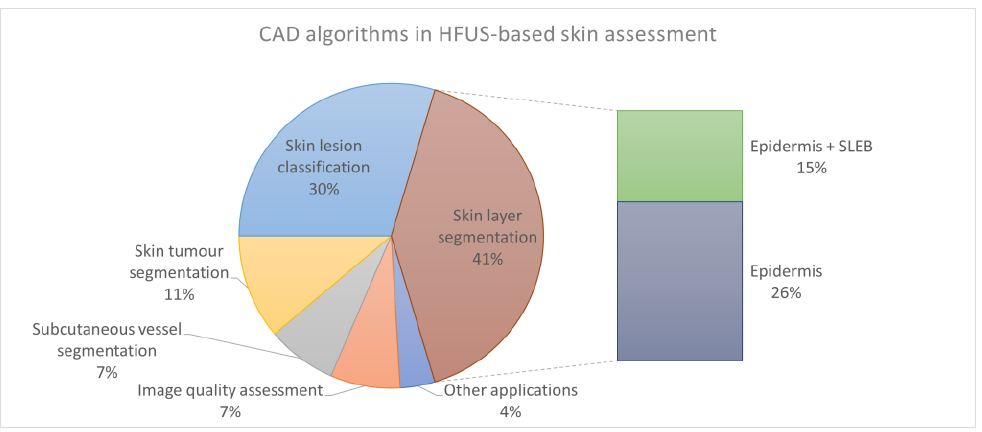
Figure 4. CAD applications in HFUS image